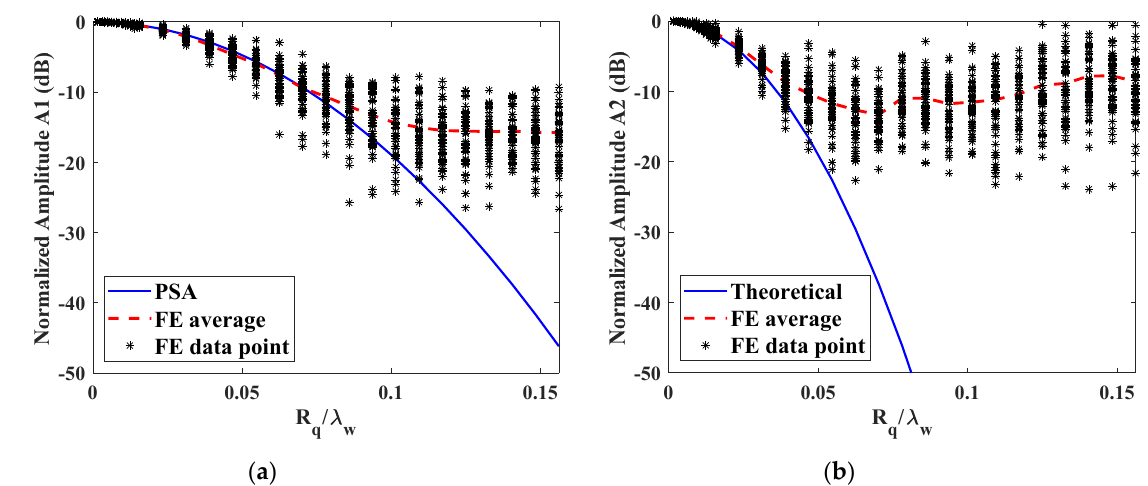
Figure 10. Variation of transmitted amplitudes from rough surfaces as a function of normalized roughness R q with respect to the smooth surface: ( a ) fundamental harmonic A1 and ( b ) second harmonic A2. The roughness is normalized by the incident wavelength λ w . Results shown for FE simulations compared with PSA